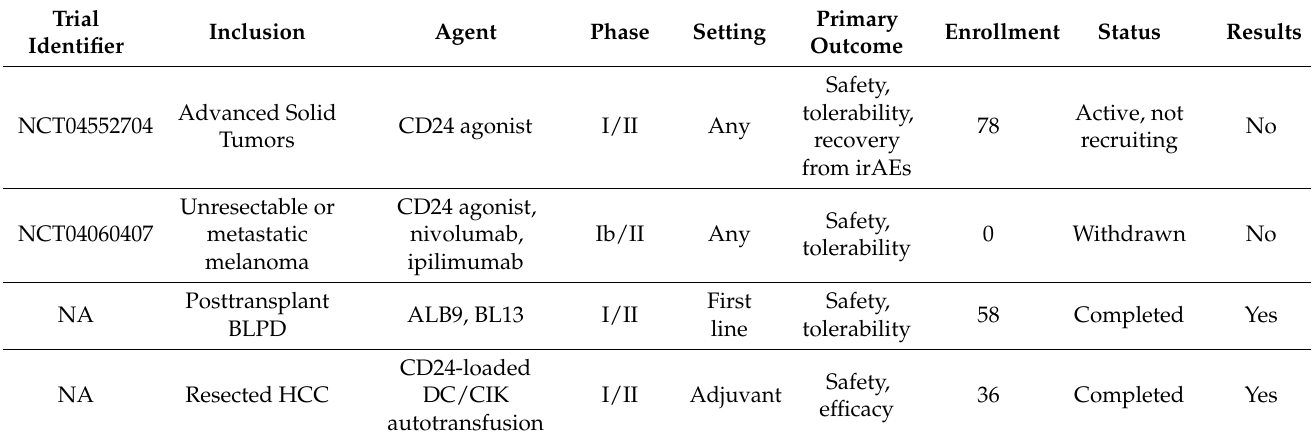
Table 4. Clinical trials with agents targeting CD24 in patients with